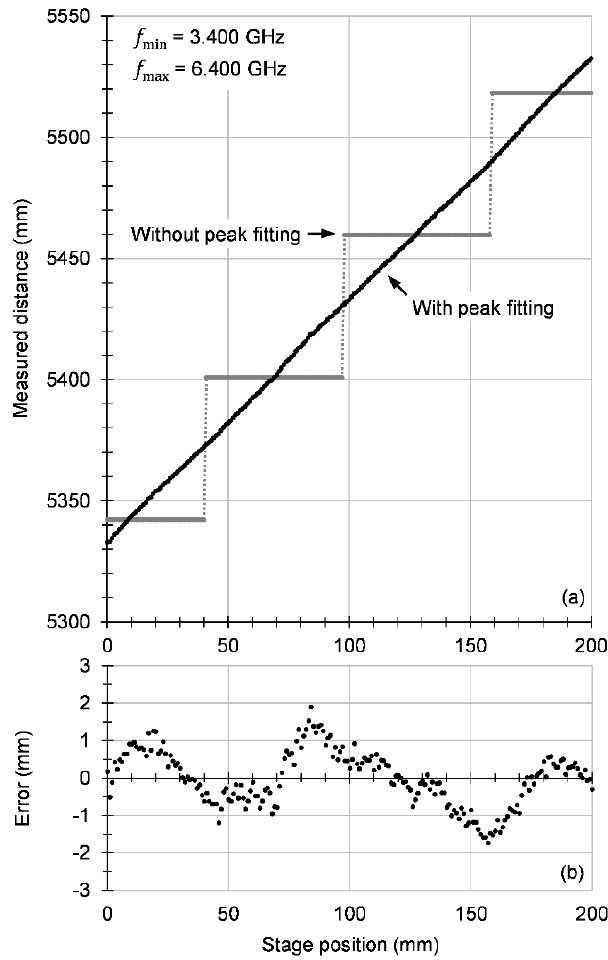
Figure 4. ( a ) Propagation distance measured by the radar in the in-line optical configuration as a function of the motor stage position. Distances calculated without Gaussian peak fitting are shown for reference. ( b ) Error of the distance measurement, defined as the di ff erences between the measured distances and a linear fit of the data with the slope fixed to 1. The standard deviation of the errors is 0.73 mm.